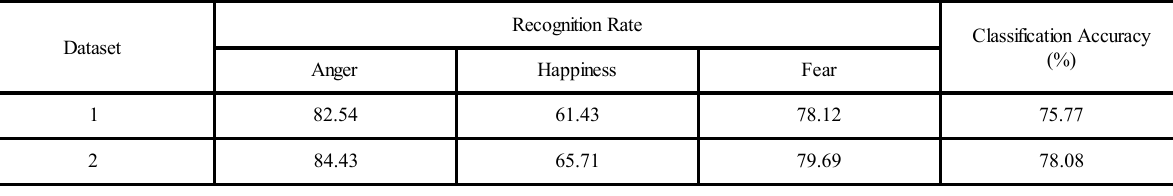
TABLE 4. CONFUSION